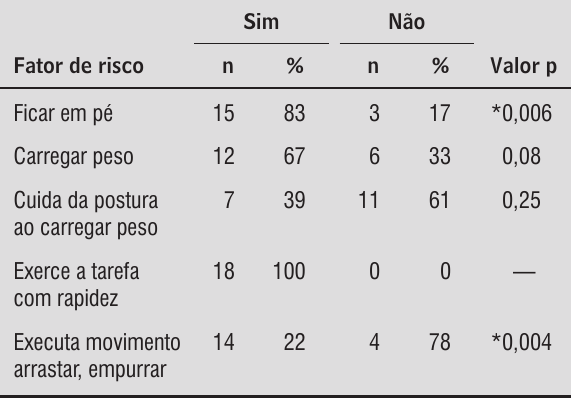
Tabela 2 - Distribuição de fatores de risco das posturas